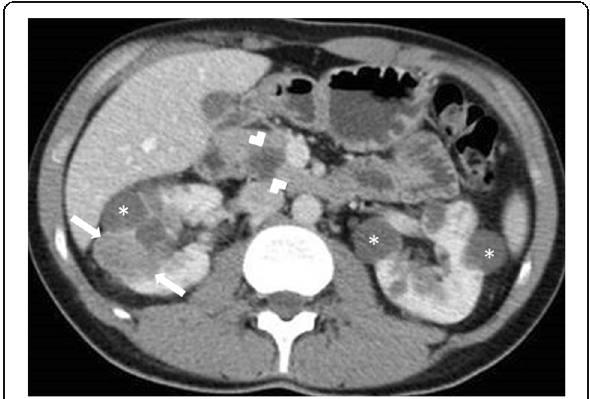
Fig. 21 A 43-year-old male patient with known VHL underwent a follow-up CT exam. Axial plane post-contrast CT image shows several renal cysts (asterisks) in both kidneys. Also note is made of a new focus of clear cell RCC (surgically confirmed) in the right kidney (arrow). A pancreatic cyst in the uncinate process was also detected